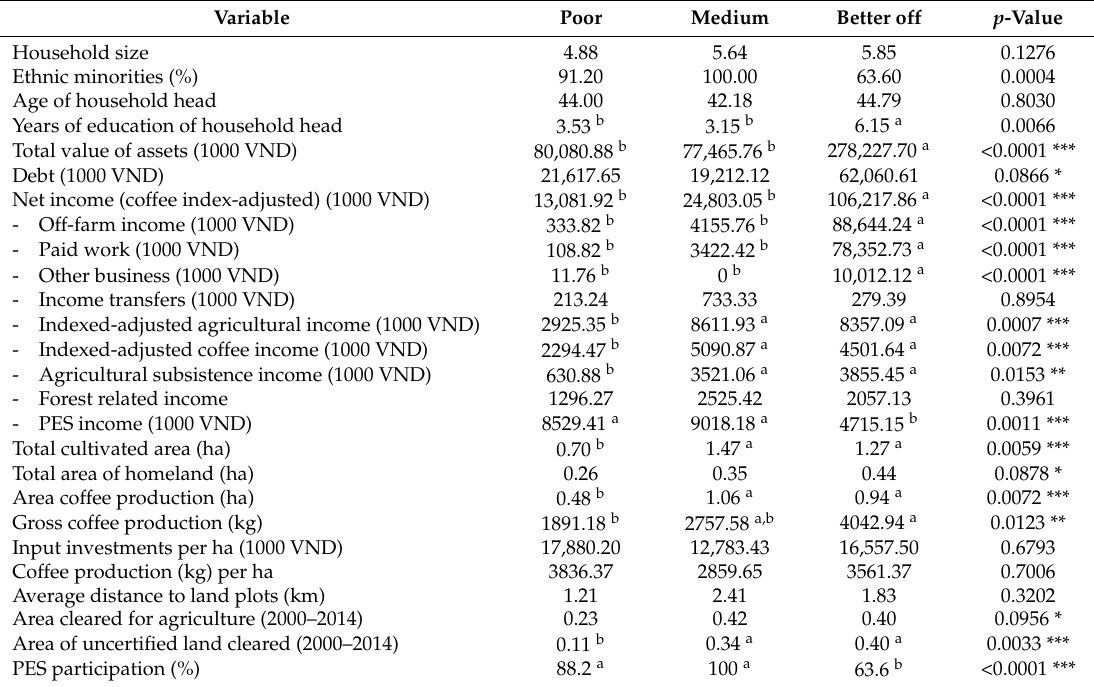
Table 3. Socio-economic characteristics, livelihood activities, and outcomes by income groups ( N